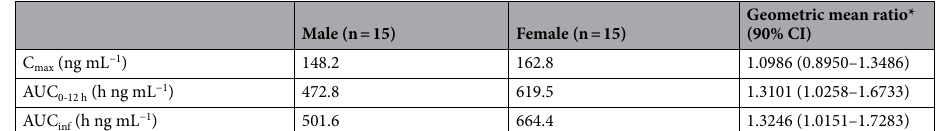
Table 2. PK parameters of zolpidem after single oral administration. *Weight normalized value; † t -test; ‡ Wilcoxon rank-sum test. All values are presented as arithmetic mean ± standard deviation except for T which median [minimum – maximum] is presented. C 8h concentration at 8 h post-dose, C 12h concentration at 12 h post-dose, C max maximum plasma concentration, T max time to reach C max , AUC 0-12 h area under the concentration curve from 0 to 12 h, AUC inf area under the concentration curve from 0 to infinity, t 1/2 half-life, Vd/F apparent volume of distribution, CL/F apparent clearance.